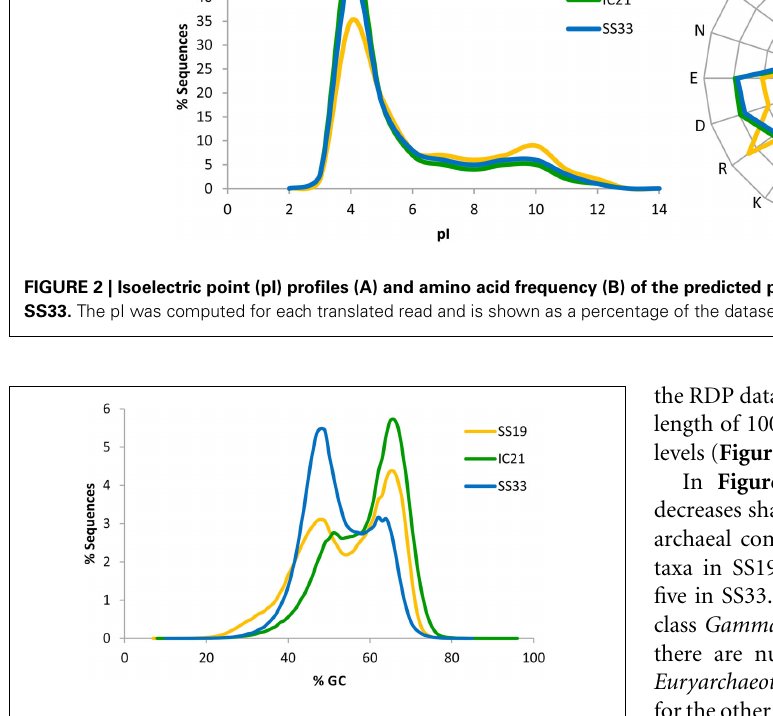
FIGURE 3 | Comparison of G + C% of sequences from metagenomic datasets SS19, IC21, and SS33. G + C% was computed for each read and the percentage of the dataset in intervals of bin width 10 is